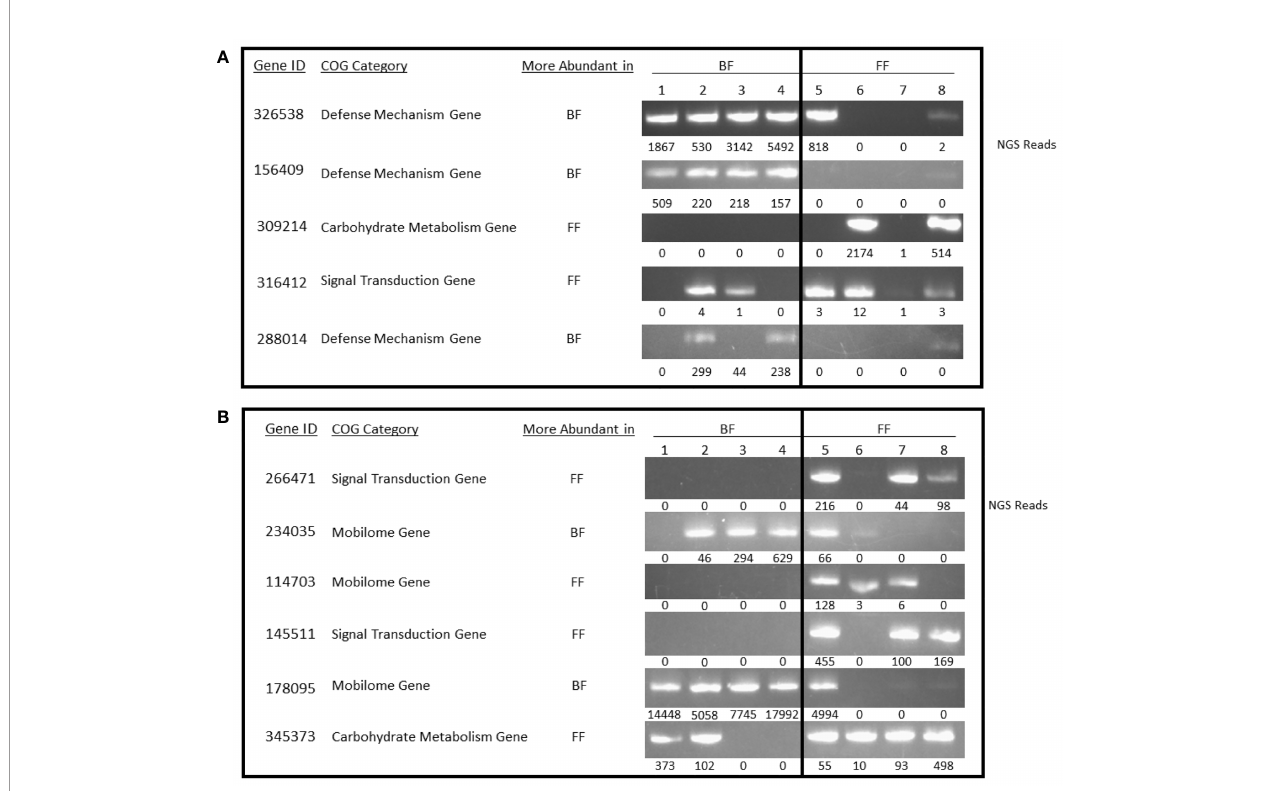
FIGURE 3 | Gene Ampli fi cation. (A, B) Non-quantitative PCR was used to validate the results of the bioinformatic analysis for 11 genes. Four representative samples from each cohort of breast-fed and formula-fed infants were analyzed using the puri fi ed DNA extracts. Next generation sequencing reads are shown under each PCR panel, as well as corresponding cohort with a higher abundance of the Clusters of Orthologous Genes category. (A) 326538, toxin component of the Txe-Axe toxin-antitoxin module, Txe/YoeB family; 156409, alkyl hydroperoxide reductase subunit AhpF; 309214, glycogen synthase; 316412, c-di-AMP phosphodiesterase, consists of a GGDEF-like and DHH domains; 288014, S-formylglutathione hydrolase FrmB. (B) 266471, chemotaxis protein CheY-P-speci fi c phosphatase CheC; 234035, conjugal transfer/entry exclusion protein; 114703, phage DNA packaging protein, Nu1 subunit of terminase; 145511, adenylate cyclase, class 3; 178095, protein involved in initiation of plasmid replication; 345373, sensor histidine kinase regulating citrate/malate